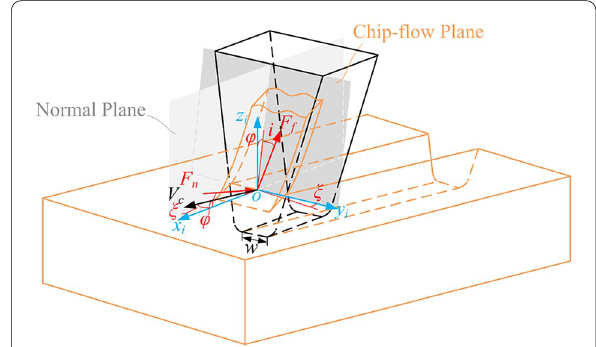
Figure 2 The thread-cutting process, with F n in the normal plane and F f in the chip-flow plane ( V c is parallel to the bone-tissue